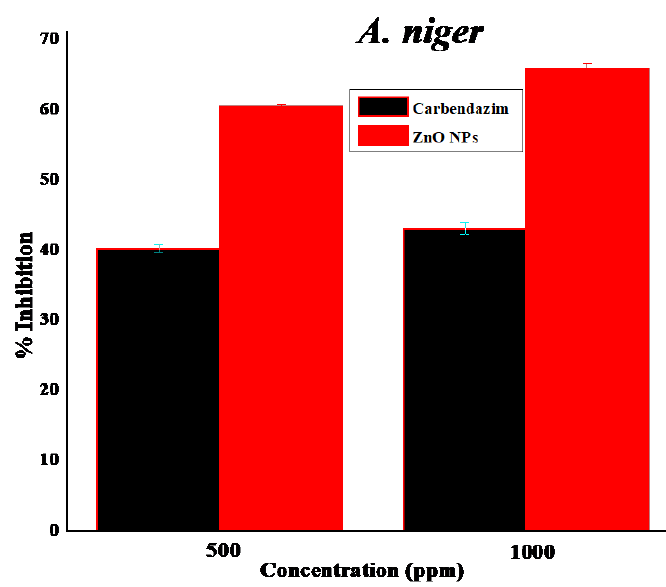
Figure 8. ZnO NPs’ anti-fungal activity against A. flavus and A. niger .